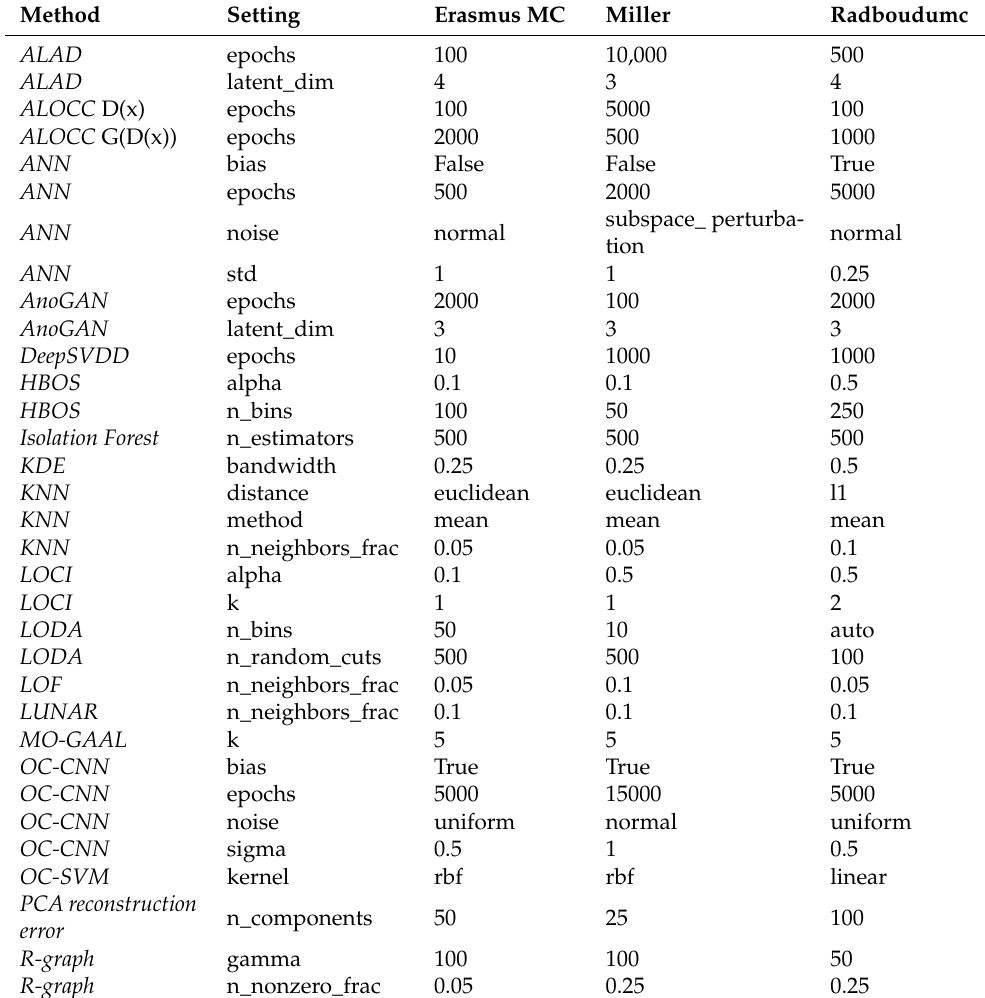
Table A2. Optimal settings for each method and dataset based on the highest average AUC across the evaluation